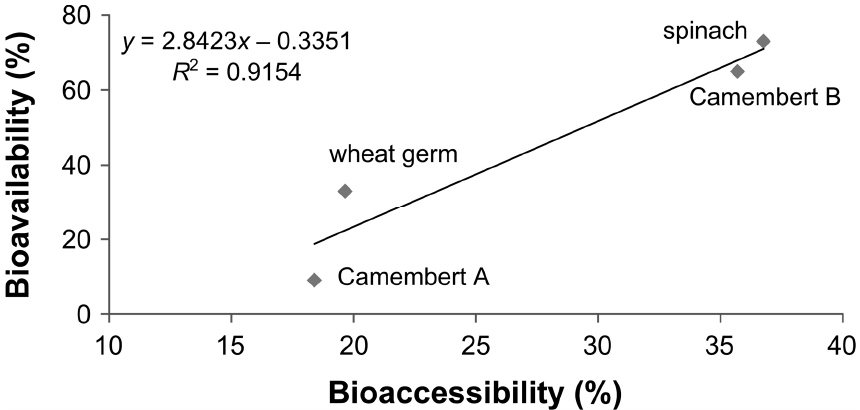
Figure 9. Correlation between bioavailability of folates [15,16] and bioaccessibility using the results from the in vitro simulation for deconjugation efficiency and stability of folates combined with the composition of folates of the foods used in the human studies.